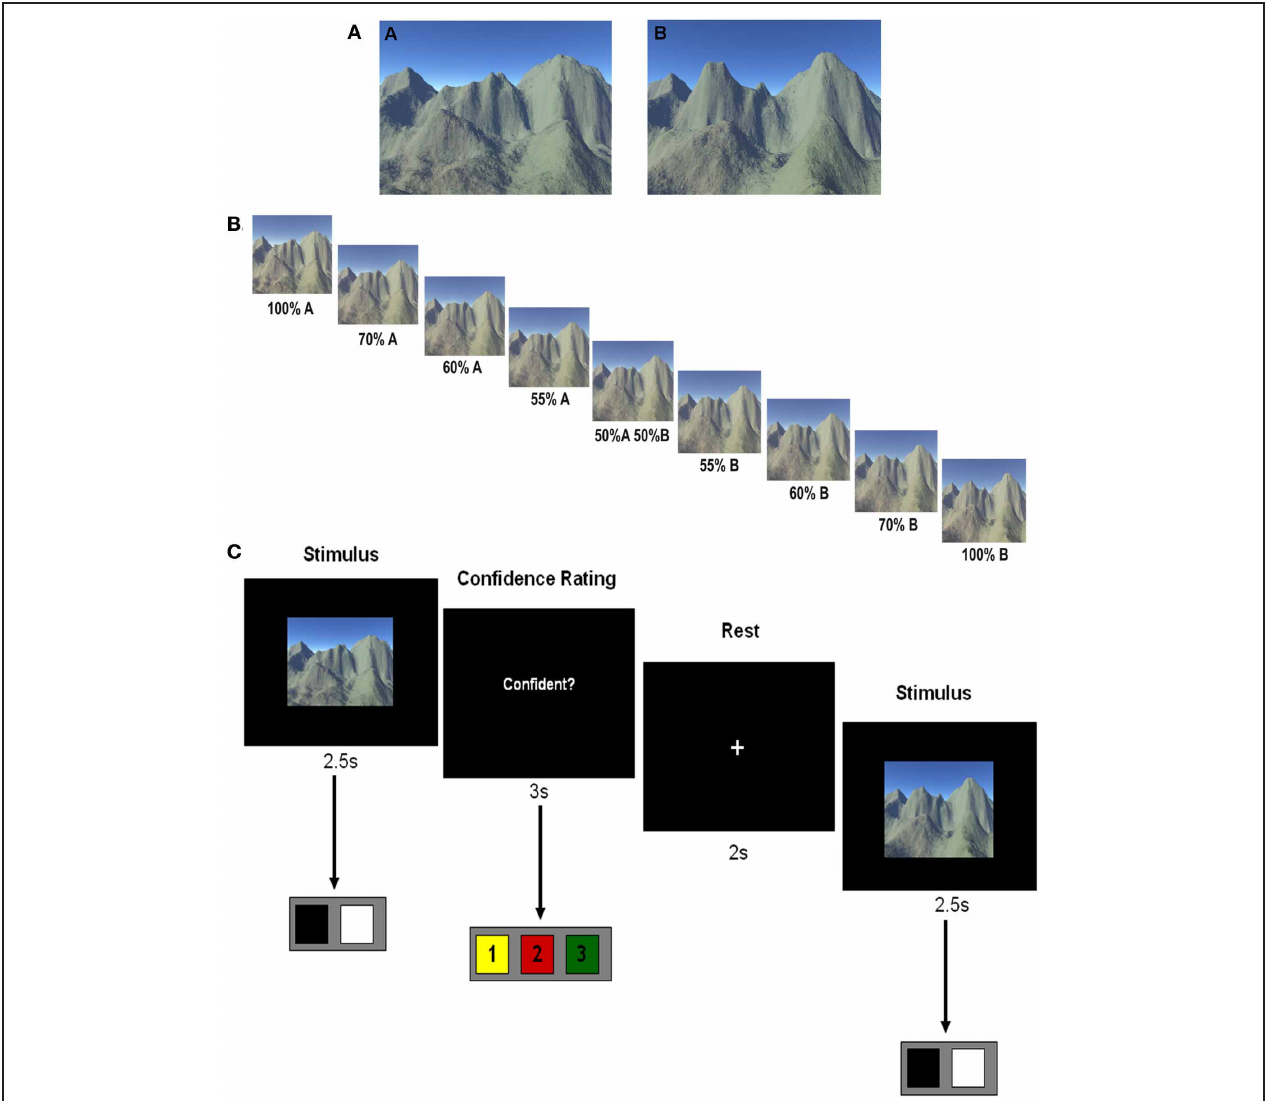
FIGURE 1 | The stimuli and experimental task. (A) The two original scenes—note they were not labeled A and B in the actual experiment. (B) The morph continuum proceeding from 100% scene A to 100% scene B. (C) A timeline of an example single trial with stimulus duration of 2.5s during